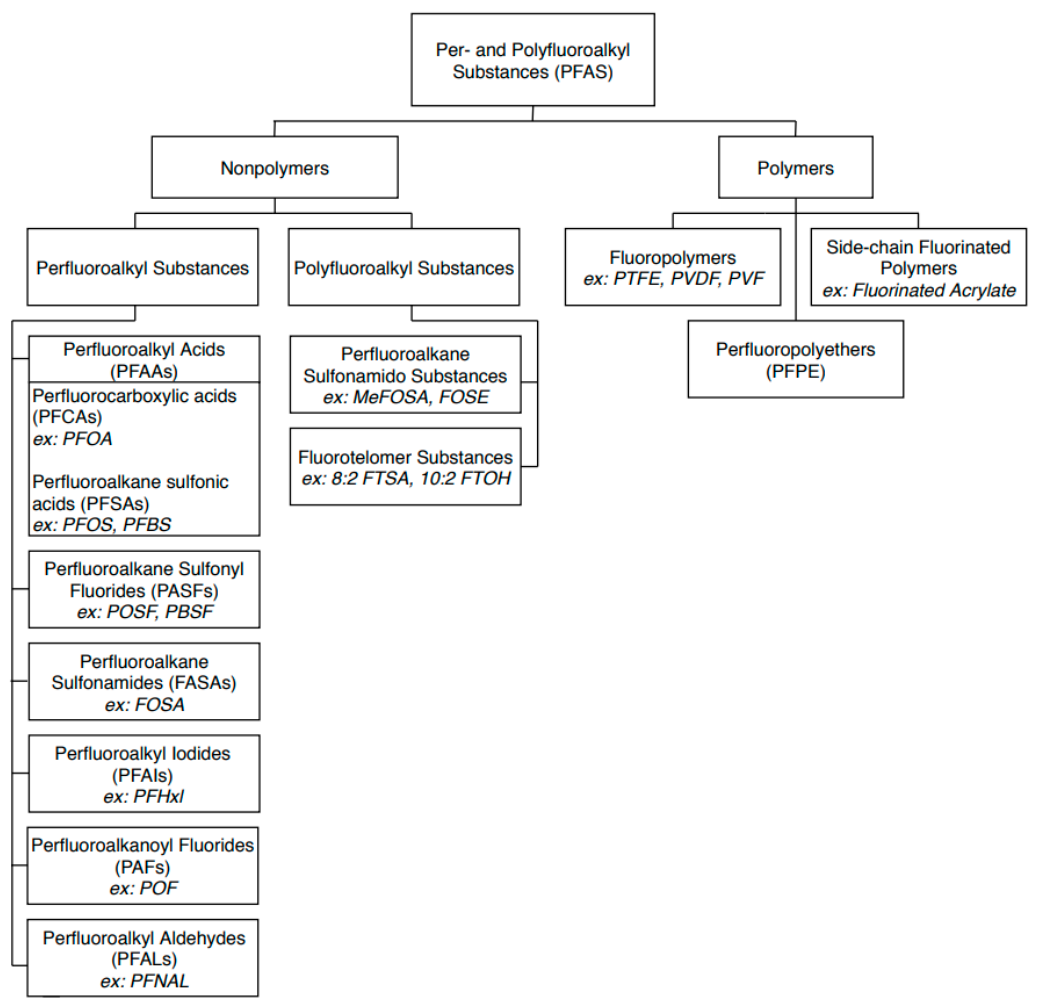
Figure 2. Classification tree of PFAS family compounds adapted from Buck et al. [3] and ITRC PFAS Team [10].